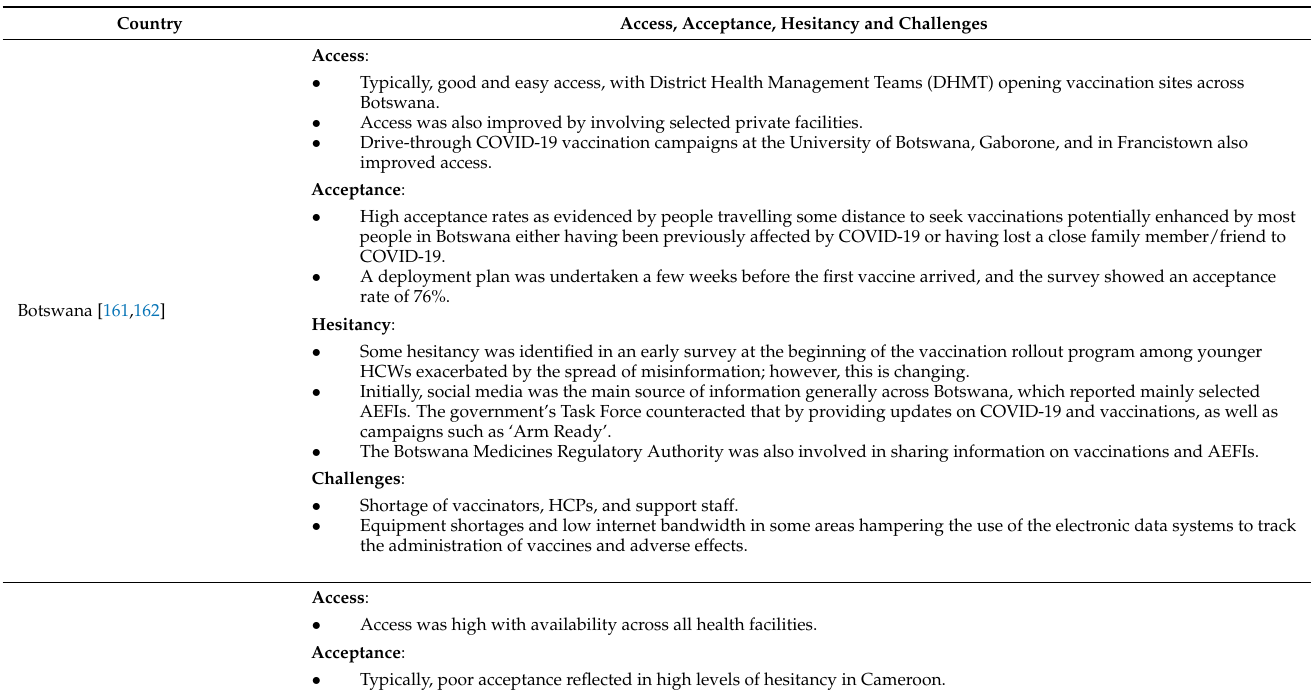
Table 4. Levels of access, acceptance, hesitancy, and challenges with COVID-19 vaccines across